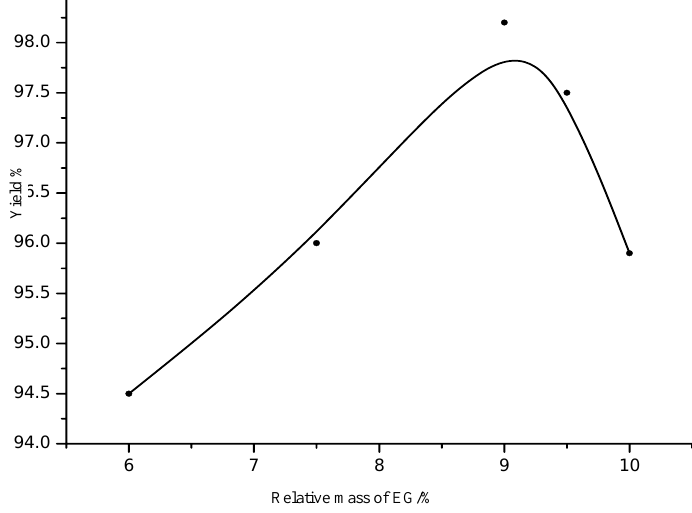
Figure 6. Influence of EG mass on ester